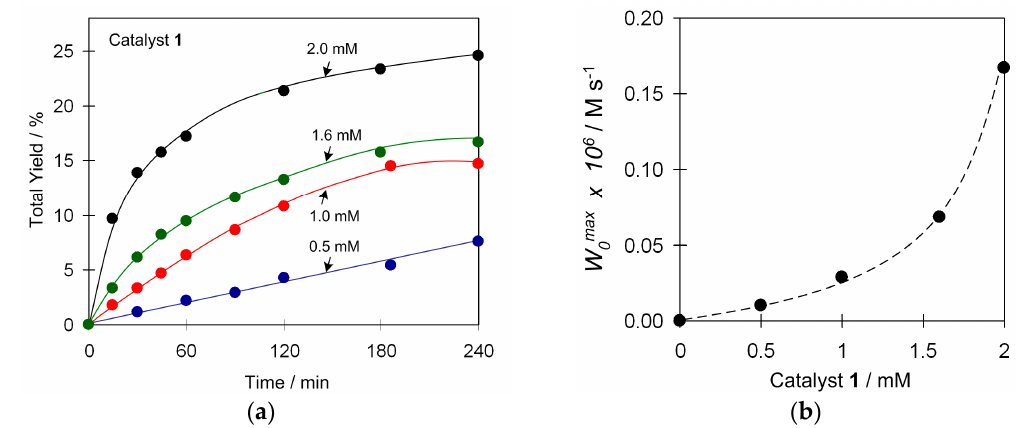
Figure 6. Effect of the amount of 1 on ( a ) the total yield of cycloheptanol and cycloheptanone and ( b ) the maximum initial reaction rate ( W 0 ) in the cycloheptane oxidation with the 1 /H 2 O 2 system. Reaction conditions: 1 (0.5–2.0 mM), acid promoter (TFA, 0.05 mmol), C 7 H 14 (1.0 mmol), H 2 O 2 (5.0 mmol), 50 °C, CH 3 CN (up to 2.5 mL total volume).